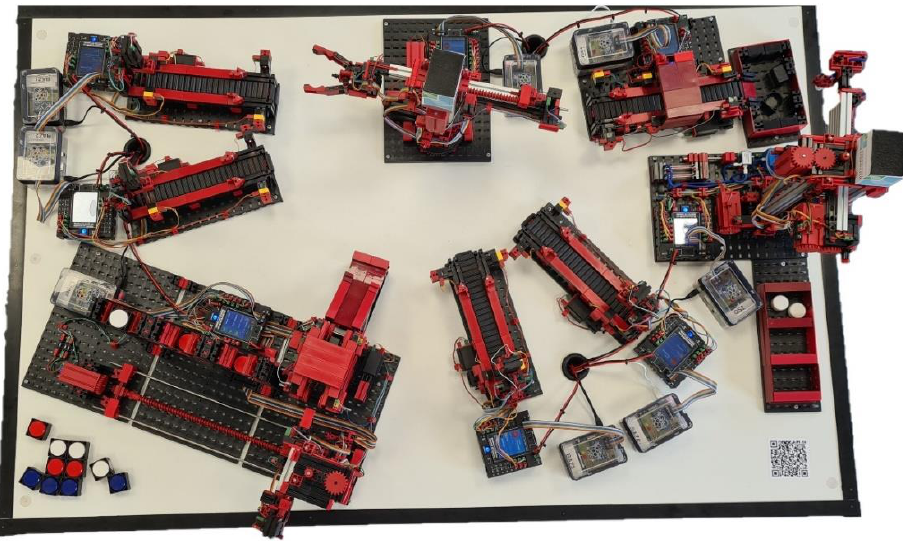
Figure 7. The structure of the Fischertechnik production system (top view).